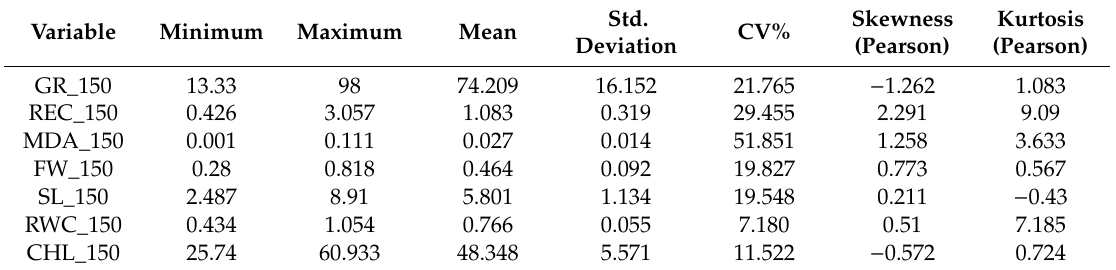
phenotypic traits abbreviated as GR, germination; REC, relative electric conductivity; MDA, melondialdehyde; FW, fresh weight; SL, seedling length; RWC, relative water content; CHL, chlorophyll content; 150,